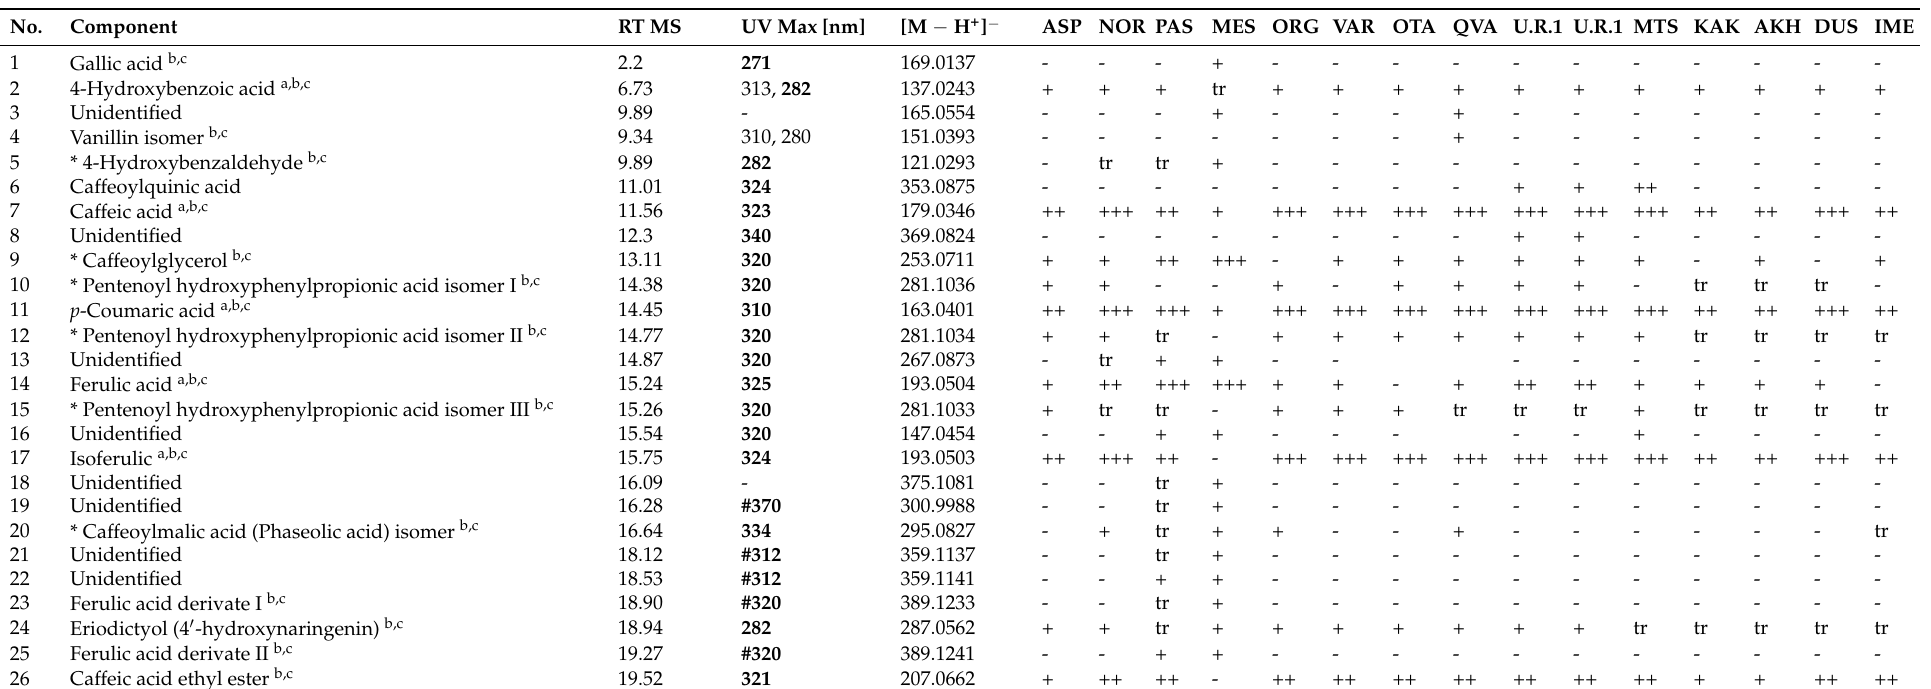
Table 2. Presence of components in UHPLC-DAD-MS/MS profile of 70% ethanolic extracts of Georgian